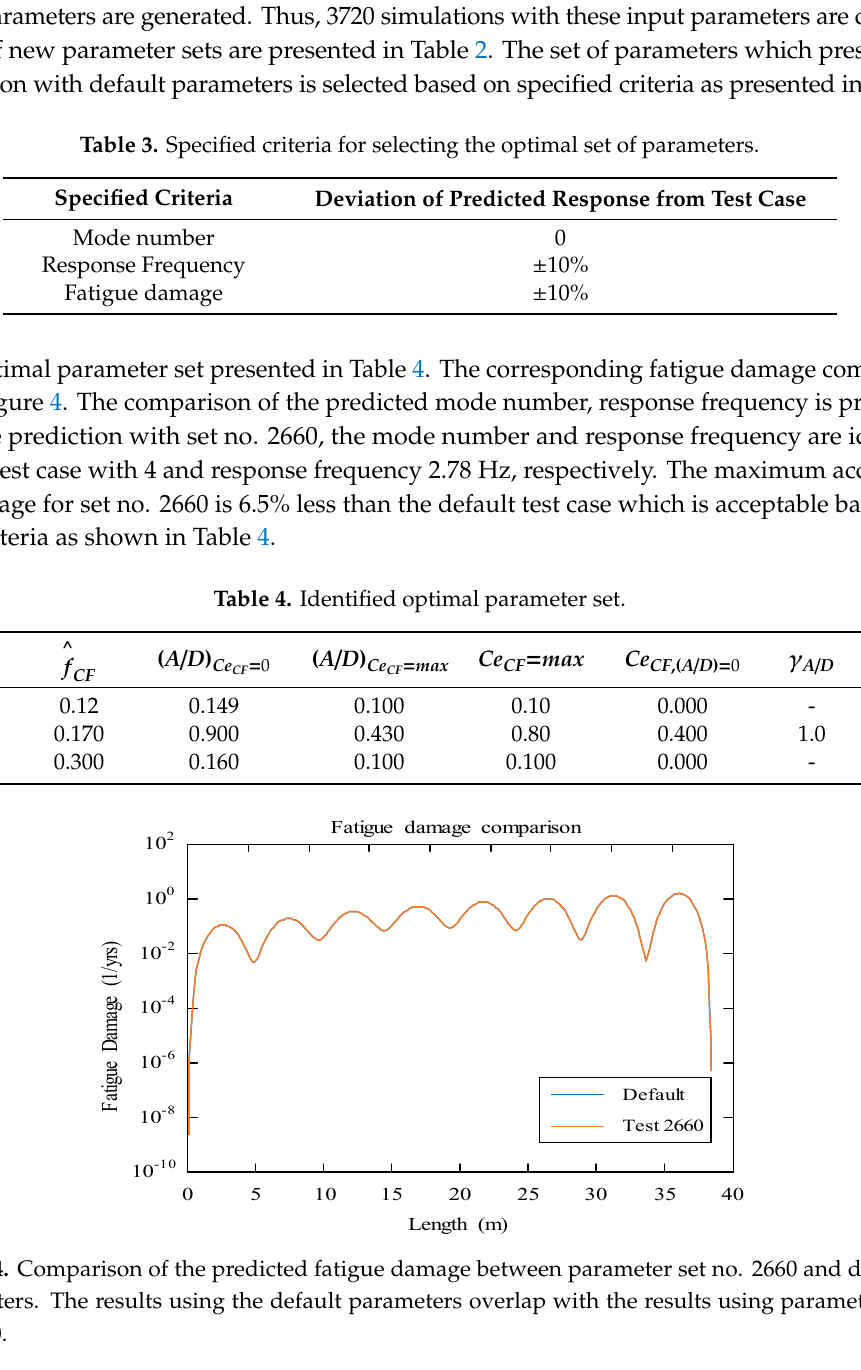
Table 3. Specified criteria for selecting the optimal set of parameters.